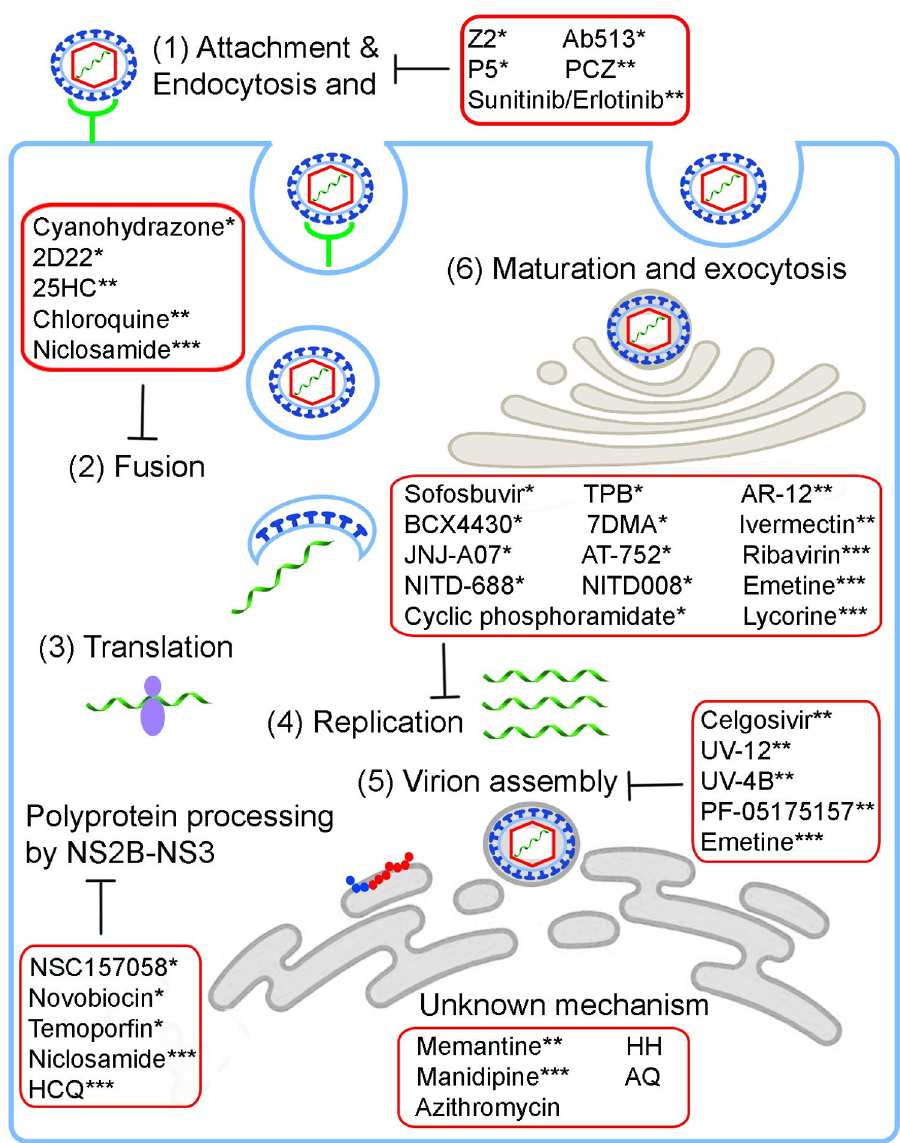
Fig 1. Drugs targeting the different steps in the flavivirus life cycle. Direct-acting antivirals � , host-targeting antivirals �� , and multitarget antivirals ��� that inhibit the different steps of the virus lifecycle discussed in this review are indicated in the red boxes. Flaviviruses consist of 3 structural proteins (C, prM or M, and E) and 7 NS proteins (NS1, NS2A, NS2B, NS3, NS4A, NS4B, and NS5), each playing distinctive roles in the different stages of the flavivirus life cycle and modulation of innate immune responses. During the virus replication cycle, the viral proteins interact with numerous host factors to modulate cellular pathways and induce infection. The flavivirus life cycle is outlined in Fig 1. (1) The E glycoprotein of the mature virion binds to the host cell membrane receptors and enters host cells via clathrin-mediated endocytosis [3]. (2) The acidic environment of the endosome triggers major structural changes in the E glycoprotein, inducing fusion of the host endosomal membrane with the viral E protein [38]. This is followed by the uncoating of the NC and the releasing of the viral genomic RNA into the cytoplasm. (3) The positive-sense viral genome (+ssRNA) is translated by ribosomes to form the viral polyprotein, which is then cleaved into structural and NS proteins by viral serine protease (NS2B-NS3) and host–cells peptidases/signalases in the ER [39]. (4) The NS proteins associate with intracellular membranes located on the surface of the ER to form viral replication complexes. The NS5 protein-derived RdRp synthesizes a complementary minus-strand RNA from genomic RNA for the synthesis of new positive-strand viral RNA [40]. (5) The newly synthesized viral RNA will then associate with the C protein in the ER to form a NC, leading to the formation of immature virions [41]. (6) Maturation and exocytosis. The assembled immature, noninfectious virion will then bud off the ER and travels through the secretory pathway to the TGN, where furin-mediated proteolysis occurs. Then, the mature virions are released from the cell surface via exocytosis [39]. C AU : AnabbreviationlisthasbeencompiledforthoseusedthroughoutFig 1 : Pleaseverifythatallentriesarecorrect :